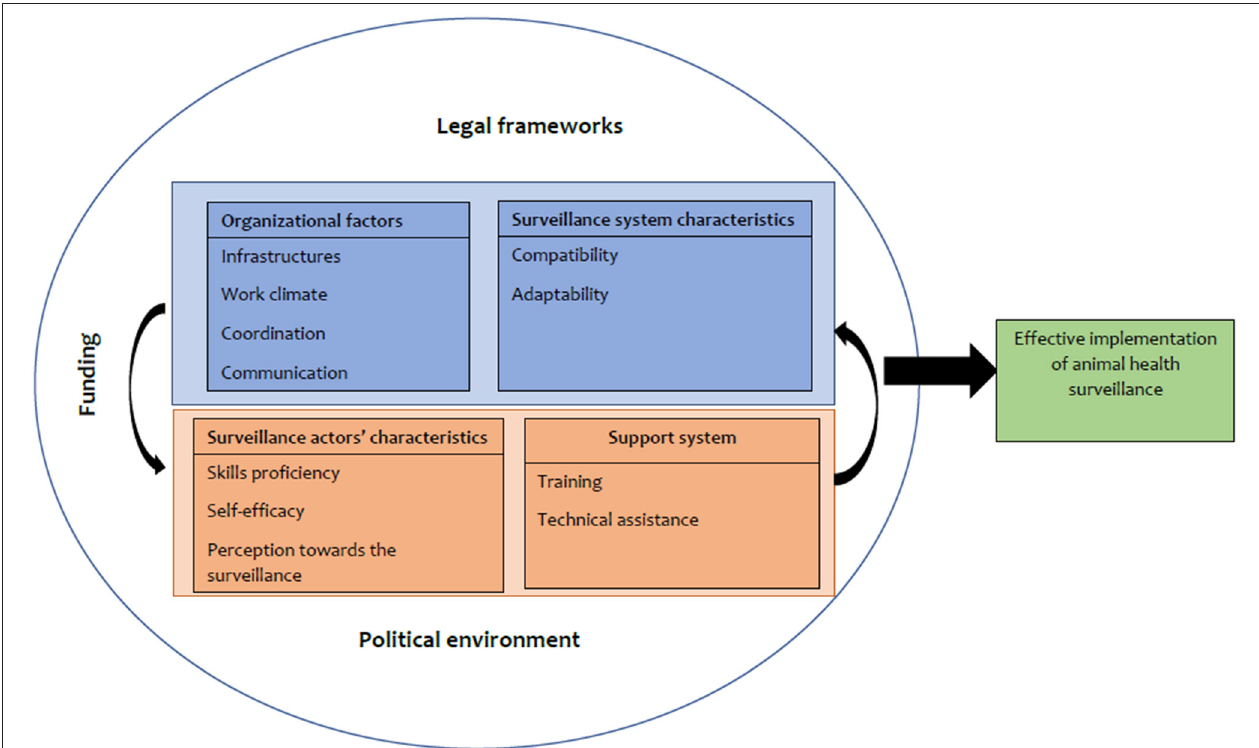
FIGURE 4 | Contextual factors for the implementation of animal health surveillance. The four compartments represent the internal contextual factors of the surveillance system surrounded by external contextual factors in the outer layer which together influence the implementation of the animal health